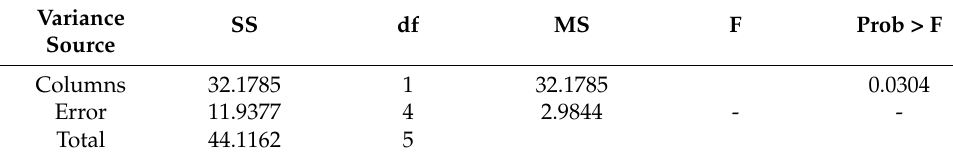
Table 3. ANOVA test on statistical time-series data based on the selected classifiers.